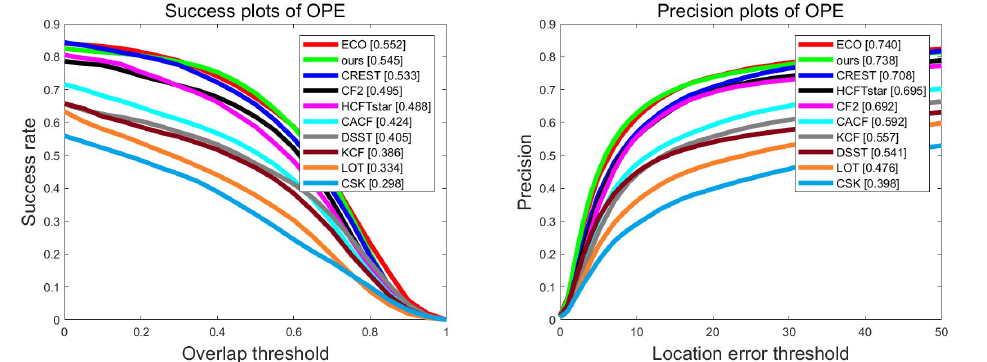
Figure 10. Success and precision rates on the TC-128